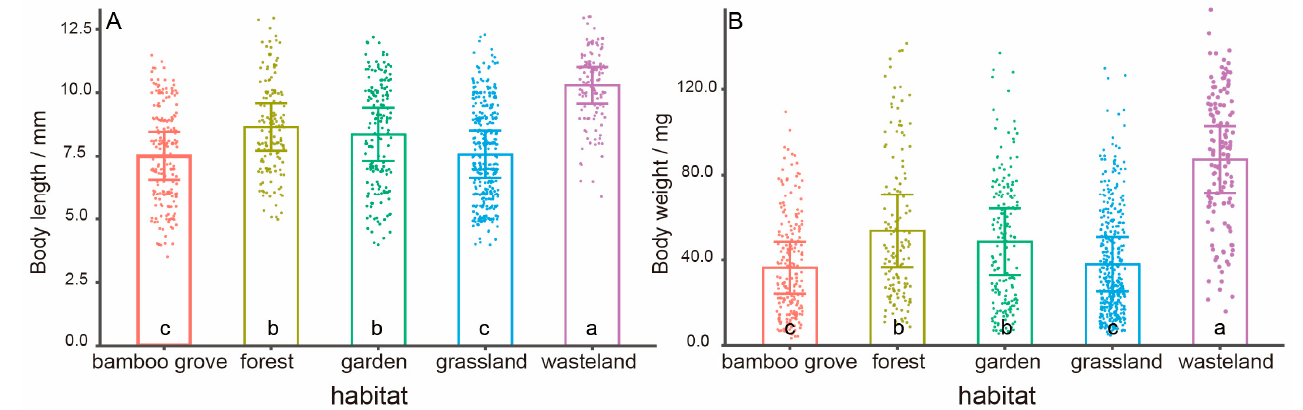
Figure 3. Length ( A ) and weight ( B ) of pill bugs (mean ± S.D.) among different habitats. Note: different letters mean significant differences.